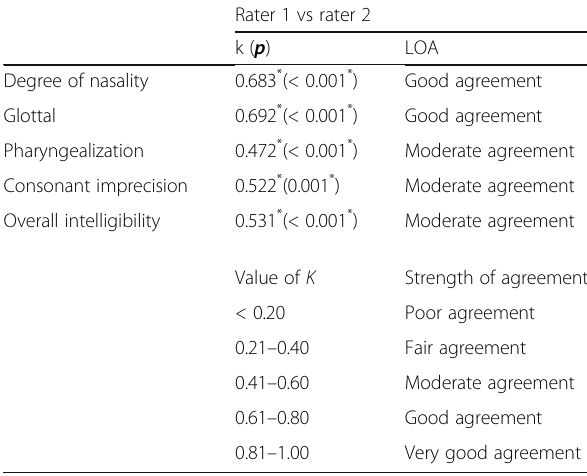
k KAPPA test, LOA level of agreement, p p value for comparing between rater 1 and 2 *Statistically significant at p ≤